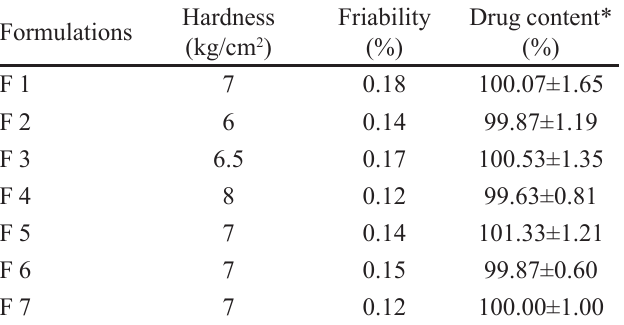
TABLE V - Evaluation of physico-chemical parameters of Compression coated tablets of PEO WSR 301 Formulations